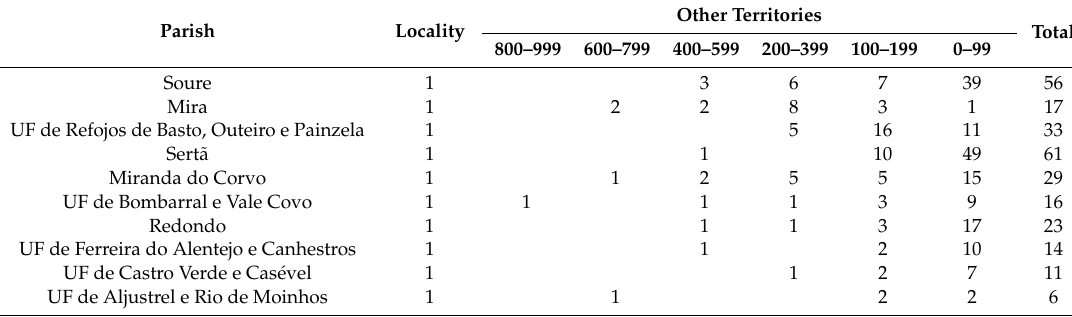
Table 6. Number of other territories belonging to APU (TIPAU) and Code 3 (DEGURBA) parishes, according to their population